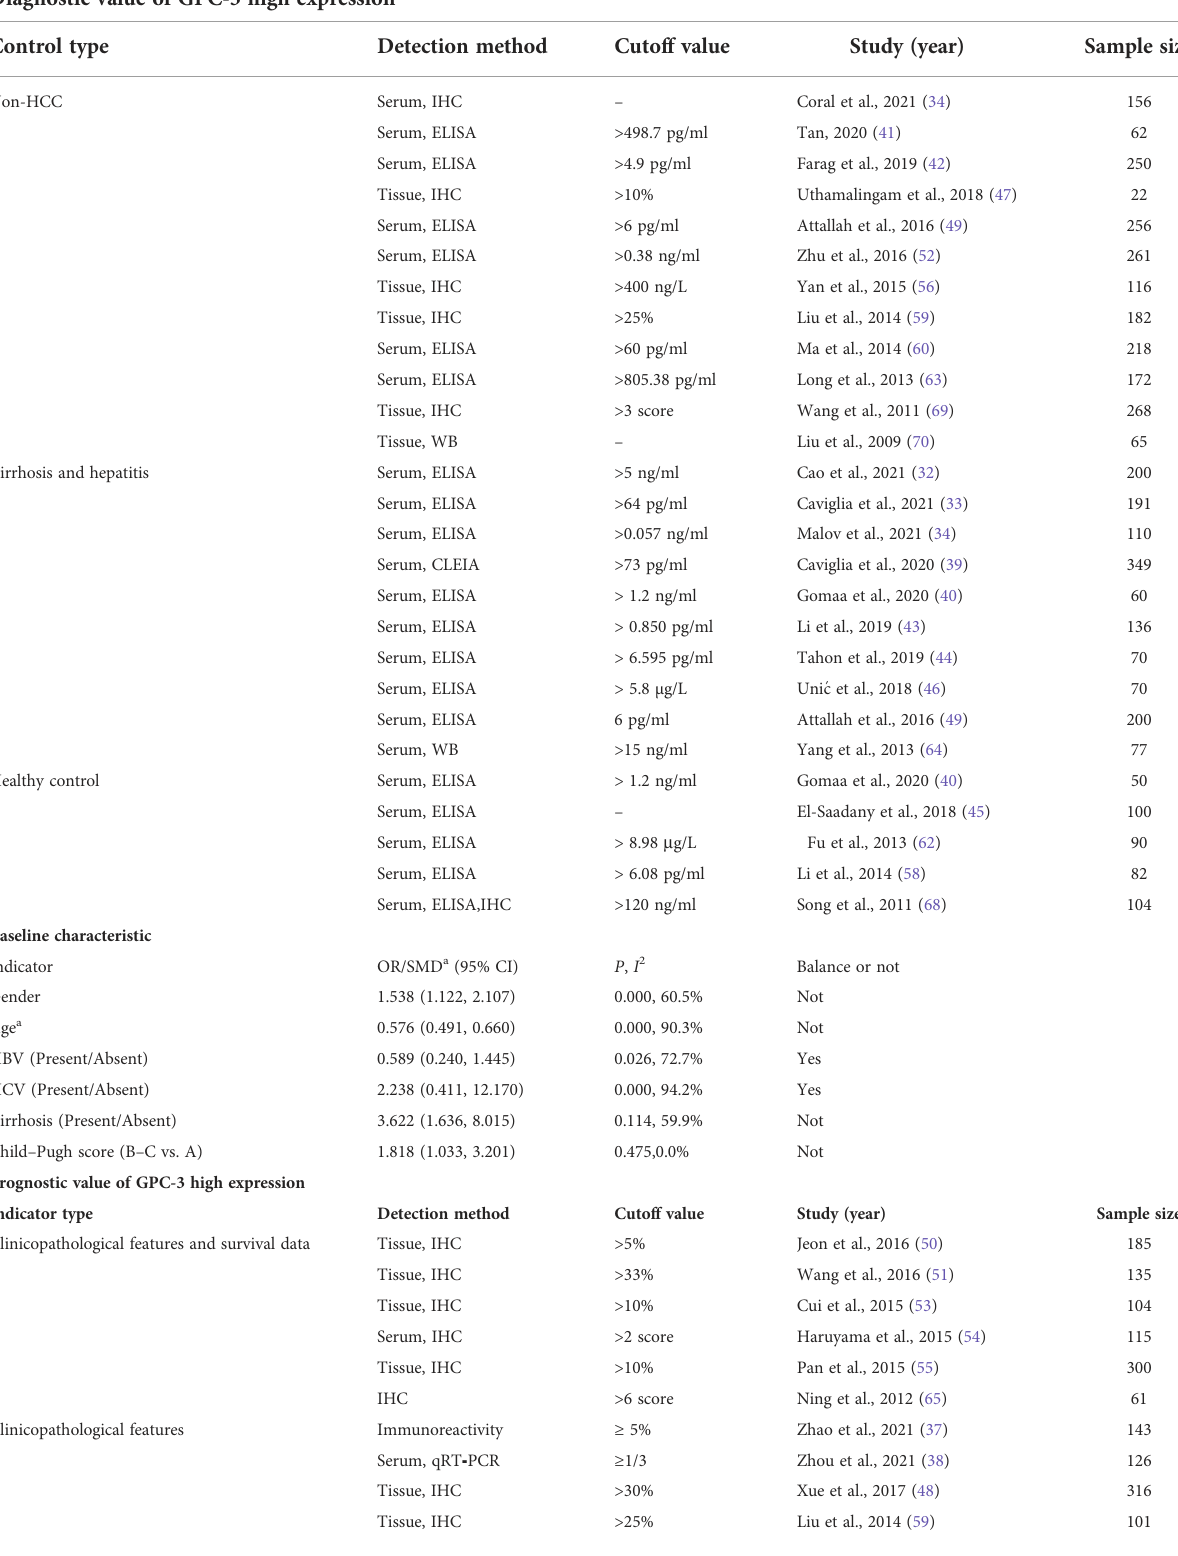
TABLE 1 Summarized of baseline characteristic of the included research